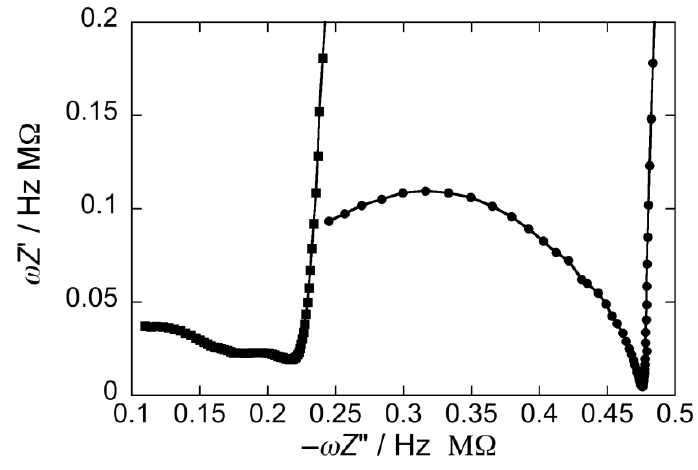
Figure 8. Plot of ωZ ’ against – ωZ ” at –0.40 V for a SAM of a DOPC/PSM (2:1) mol% lipid mixture in a pH 5.4 unbuffered solution of 0.1 M KCl in the absence of CSF114 (solid circles) and in the presence of 2 μg/mL CSF114 (solid squares). CSF114 permeabilizes the DOPC/PSM SAM towards Cd 2+ ions to an appreciable extent, as